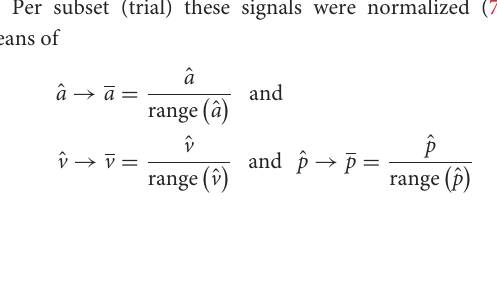
Figure 1 contains a schematic of the pre-processing steps and the implemented machine learning approach. Further details are presented in the